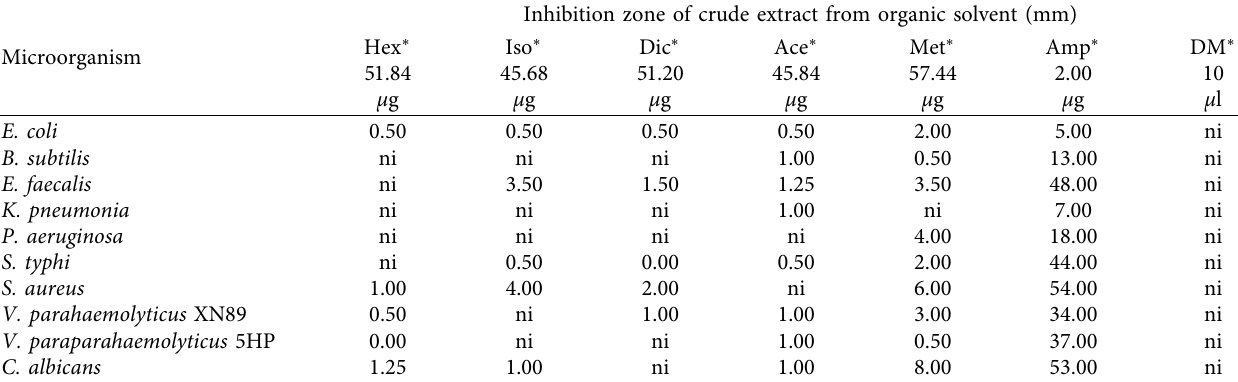
Table 2: Inhibition zone of crude extract from P. retrofractum by agar disk diffusion assay. Inhibition zone of crude extract from organic solvent (mm) Microorganism